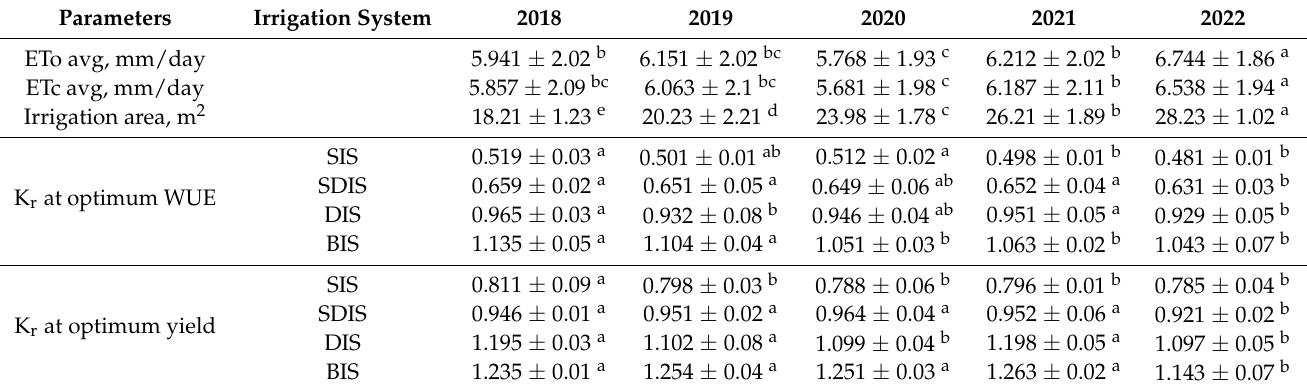
Table 2. Comparison among average yearly values ( ± standard deviation) of reference evapotranspi- ration (ETo), crop evapotranspiration (ETc), target irrigation area, and the reduction coefficient (Kr) at optimum WUE and date palm yield for the five